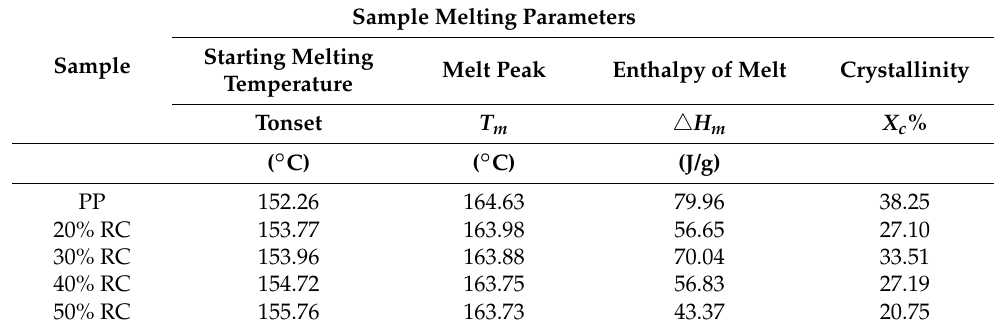
Table 2. Thermal behaviors of PP and RC/PP